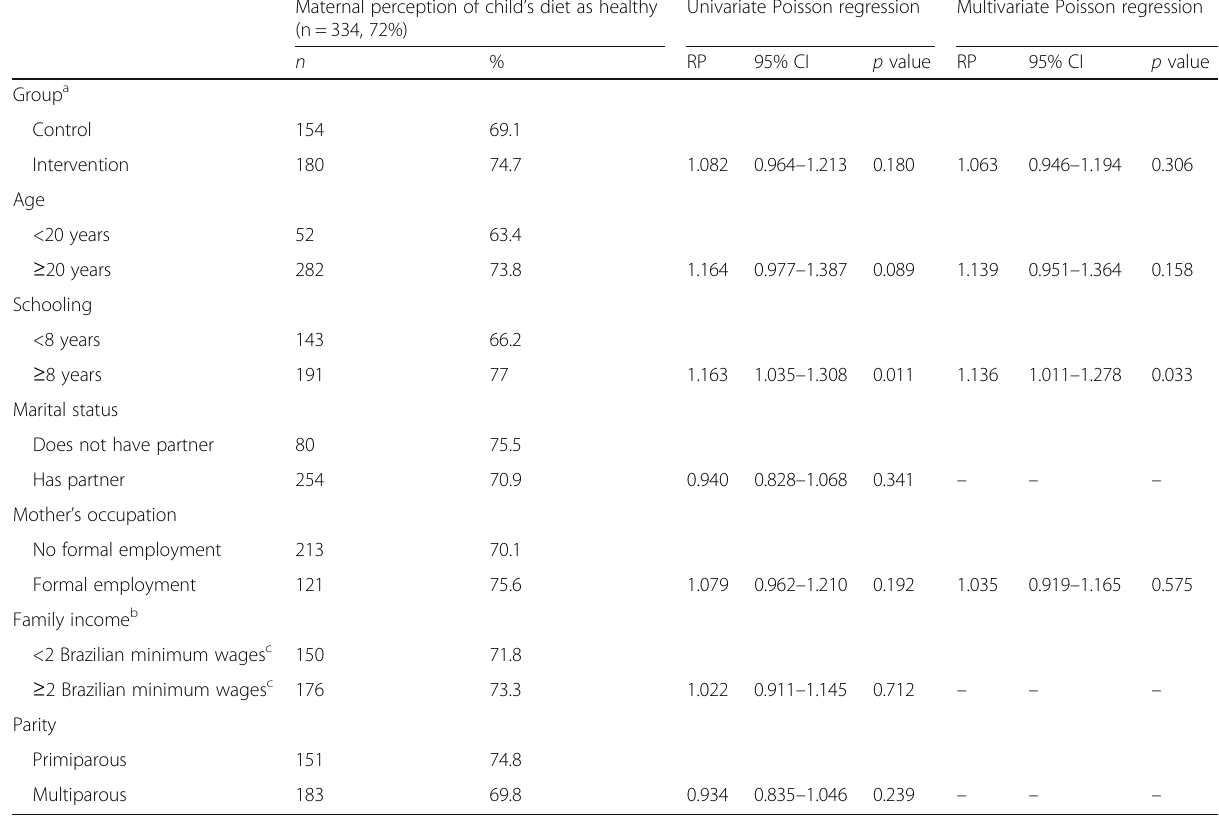
Table 4 Association between mothers ’ perception of their children ’ s diets and personal and family characteristics ( n =